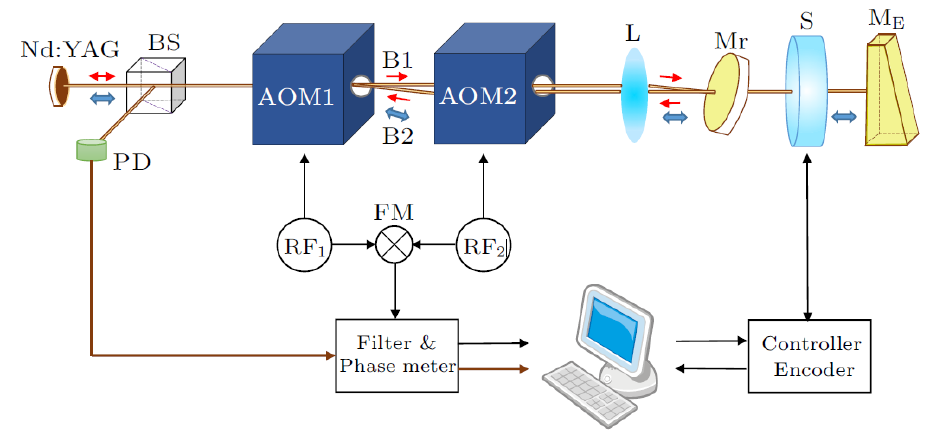
Figure 13. Configuration of the refractive-index and thickness measurement using laser feedback interferometry. BS, beam splitter; PD, photo detector; AOM 1 and AOM 2 , acousto-optic modulators; L, lens; Mr, reference mirror; S, sample; ME, optical wedge (measurement mirror); RF 1 and RF 2 , radio frequency signal generators; FM, frequency mixer. (Figure reproduced from Ref. [73]).